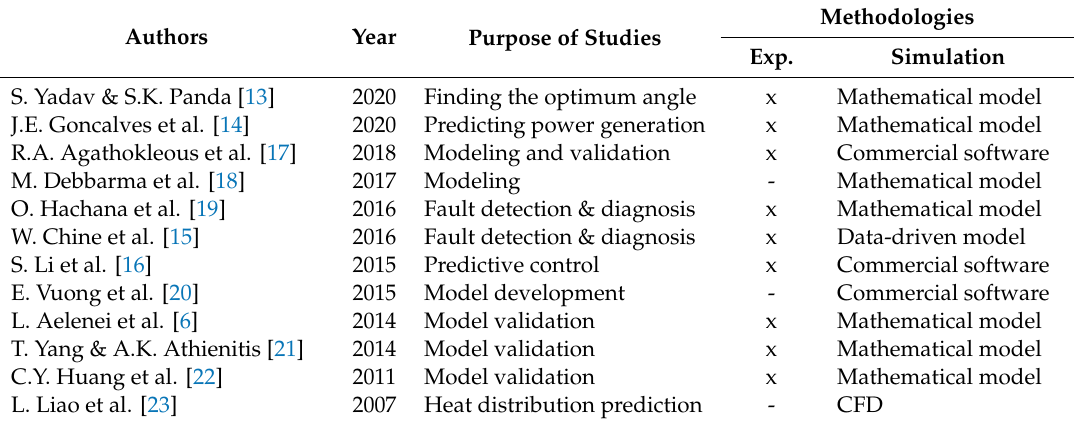
Table 1. Brief review of research on the BIPV